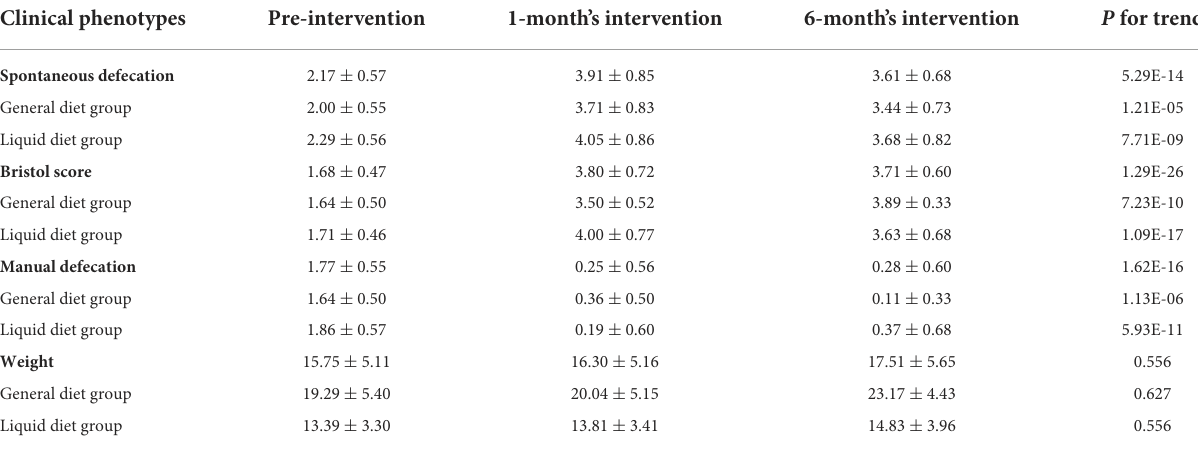
TABLE 2 Defecation and weight in two groups at pre-, 1-month, and 6-month intervention. Clinical